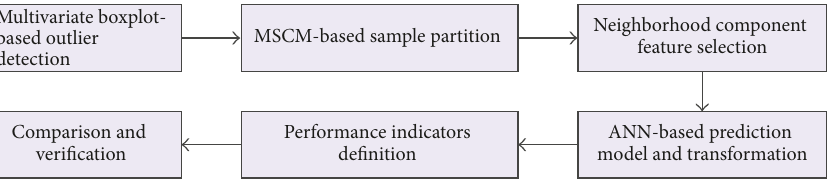
Figure 3: Main flow of the proposed approach.